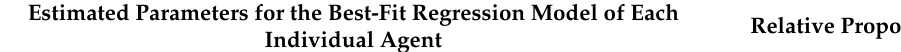
Table 1. Parameters for the SCFAs agents in the SRB